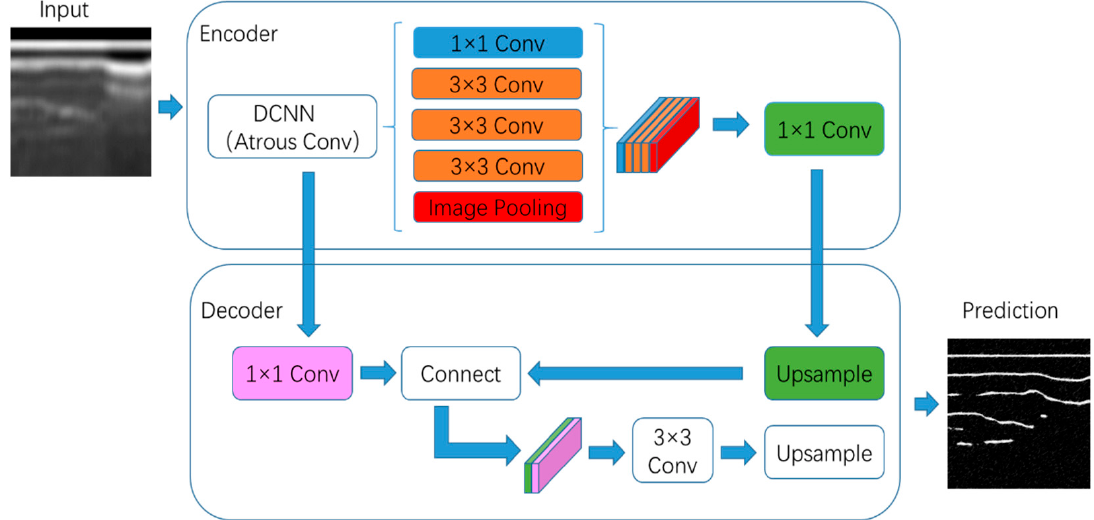
Figure 5. The architecture of the DeeplabV3+ net. DeepLabv3+ contains an encoder-decoder structure. “DCNN” represents deep convolutional neural networks. “Conv” represents the convolutional layer. The number before “Conv”, such as “3 × 3”, represents the size of the convolution kernel.